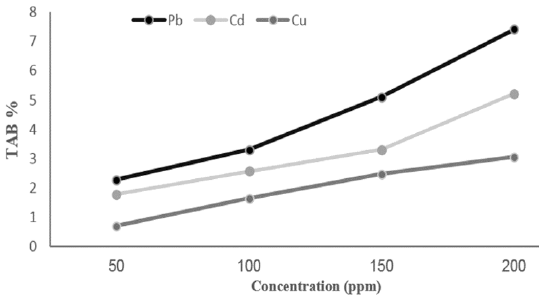
Fig. 1. Relationship between total abnormality (TAB%) and heavy metal concentration. Table 1 . Different types of heavy metal-induced chromosomal abnormalities at various stages of mitosis, MI% and TAB% in root tip cells of Trigonella